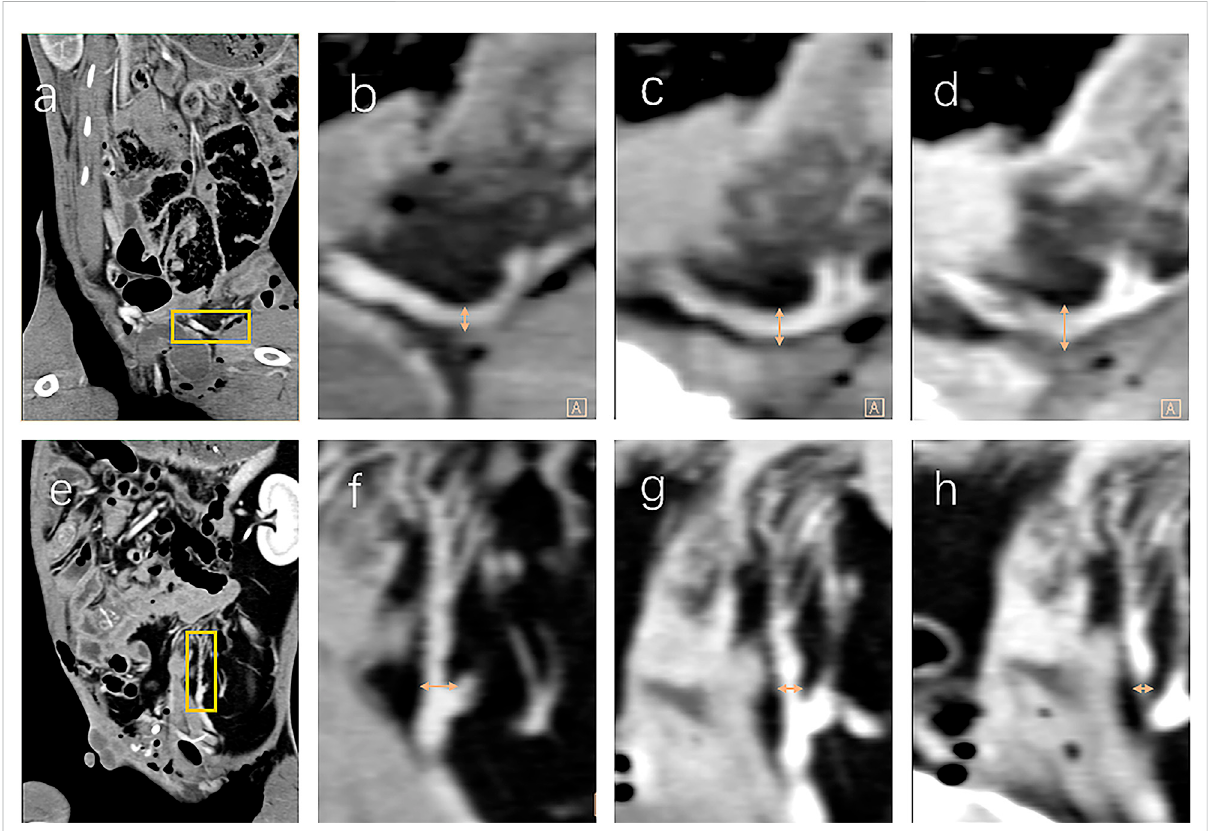
FIGURE 1 Foreachrow(Figures1A – H),the fi guresarefromthesamerabbits.Thecomputedtomographysagittalplaneshowstheabdominalcavityofthe rabbit and the uterus is marked with a yellow square (Figure 1A). After magni fi cation, the initial distance of the uterine artery (Figure 1B), the blood vesselsdilateafter15 min(Figure1C),untilthedilationisobviousat30 min(Figure1D).Sagittalplanescanofanotherrabbitwiththeuterusmarkedby the yellow square (Figure 1E). Initial distance of the uterine artery (Figure 1F), vasoconstriction at 15 min after high dose ephedrine (Figure 1G), and fi nal severe contraction at 30 min (Figure 1H). High-density shadows in surrounding organs due to penetration of contrast media, but the blood vessels are severely stenotic, or even transiently interrupted (Figure 1H). The diameter of the uterine artery is marked with a yellow arrow.